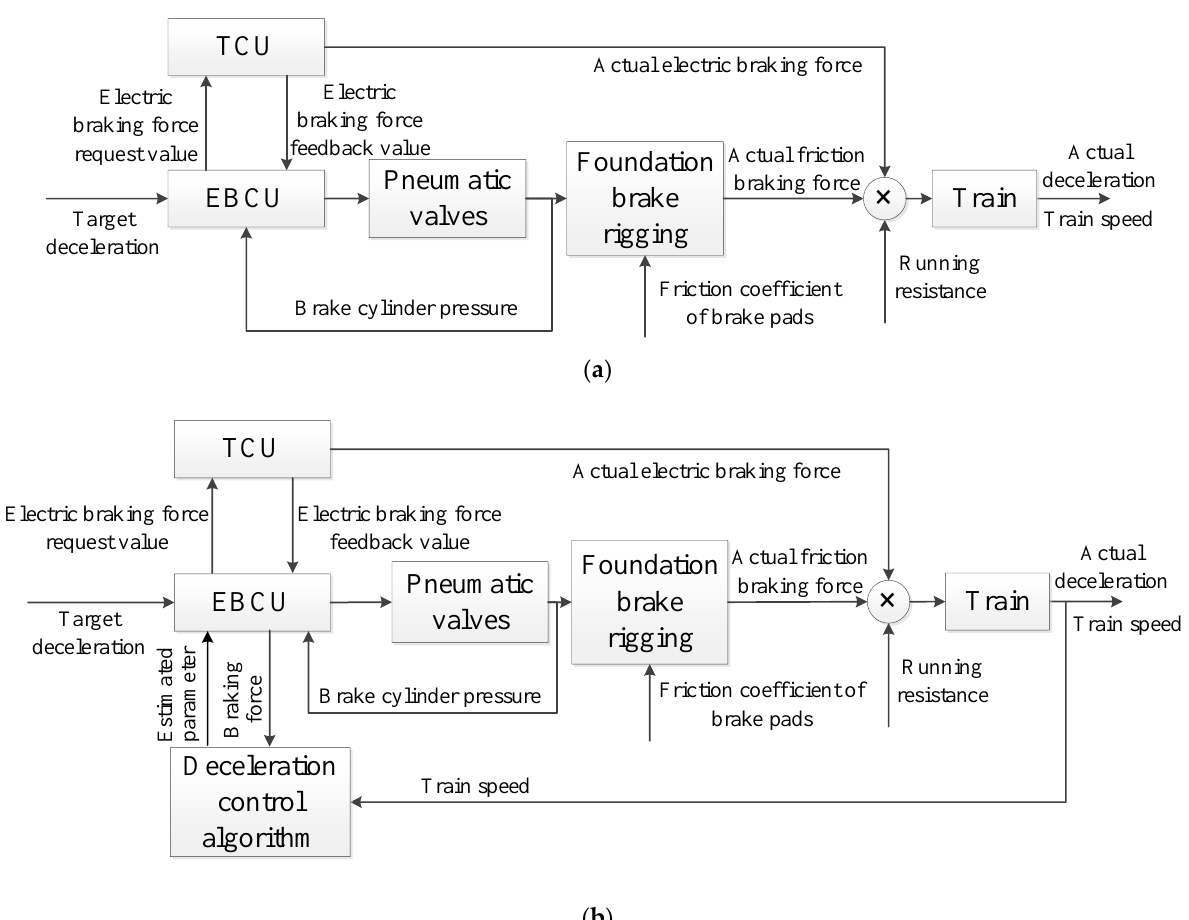
Figure 2. Schematic diagram of the braking control mode: ( a ) conventional non-deceleration control mode; ( b ) deceleration control mode.